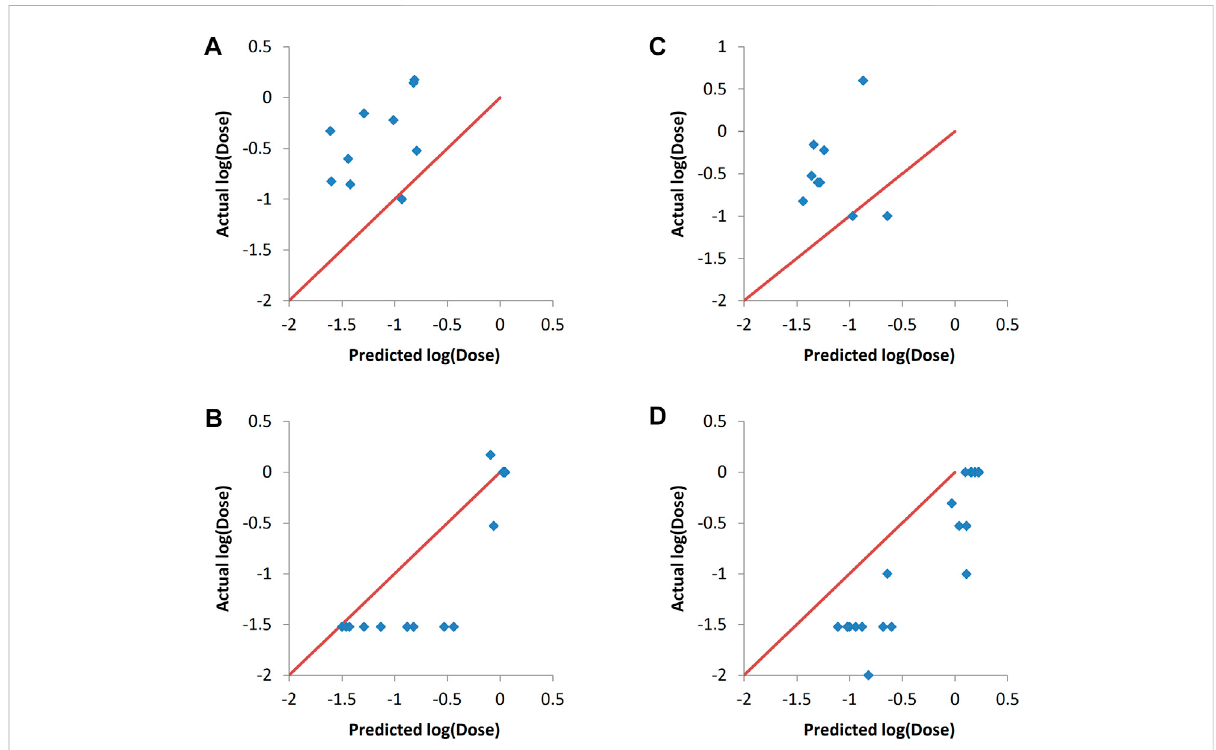
FIGURE 6 Actual vs predicted responses of validation sets after setting the values of the PEG mol% descriptor to either the minimum value (A, C) or the maximumvalue (B,D) .ThemodelingwascarriedoutbyANN. (A) and (B) validationsetone. (C) and (D) validationset2.Thevalidationsetsentrieswith theactual PEG mol% beingtheminimumvaluewereomitted fromA and C,while those with theactual PEG mol%being themaximumwereomitted from B and D for visualization clarity.